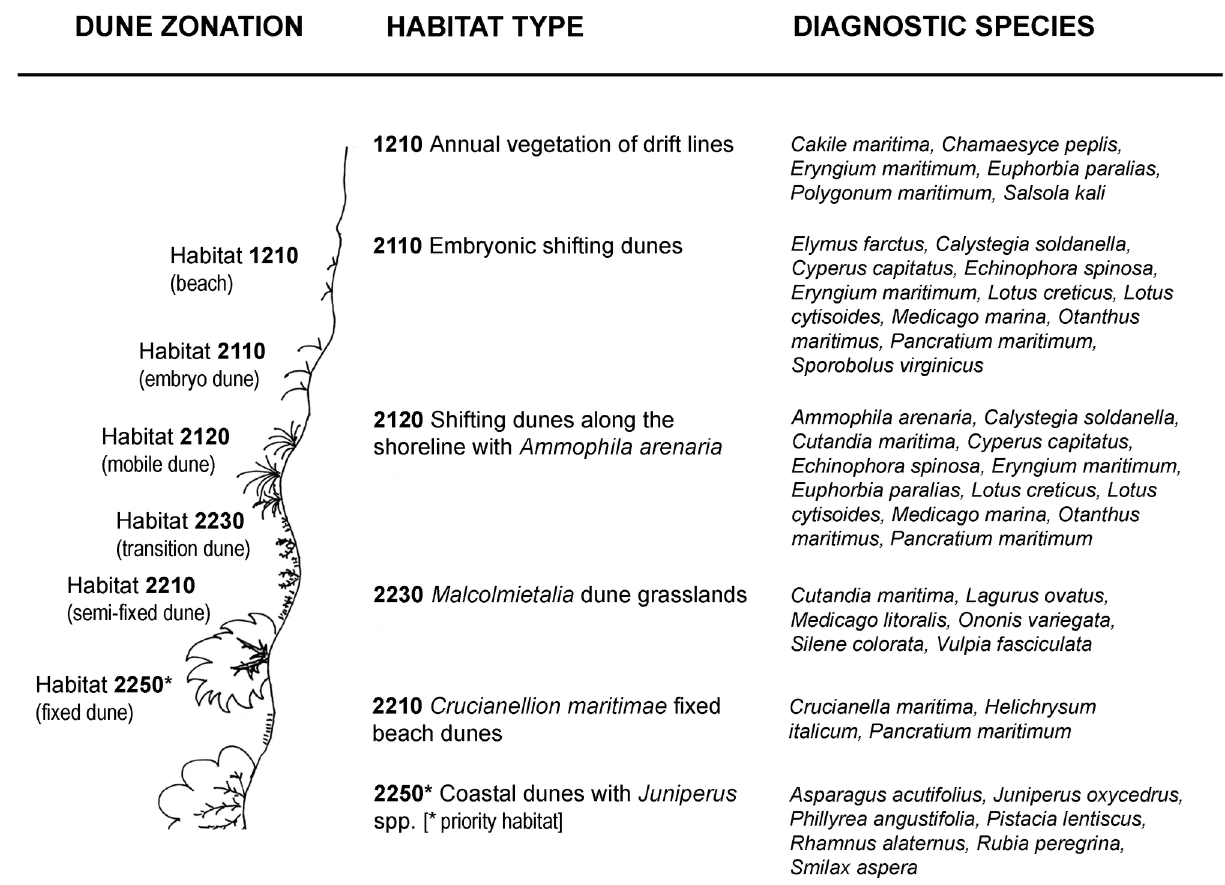
Figure 1. Habitat types and diagnostic species. List of the habitat types considered with corresponding diagnostic plant species (as defined by Interpretation Manuals of Habitats Directive) used in the “indirect